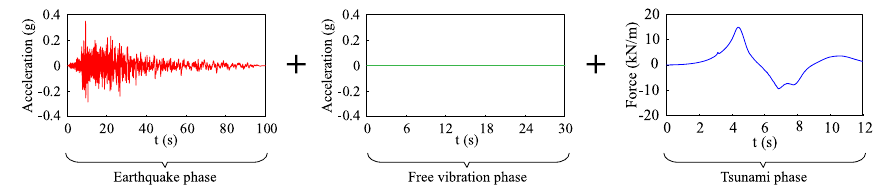
Fig. 7 Conceptual diagram of the input earthquake-tsunami sequences